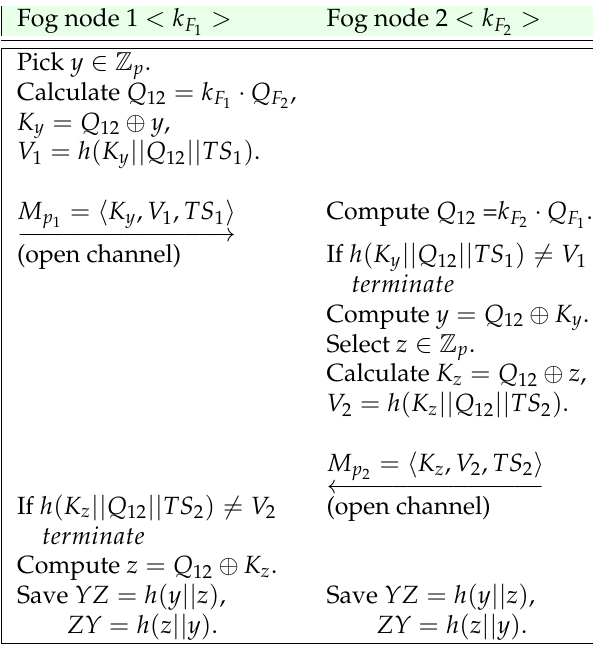
Figure 3. Summary of Fog node